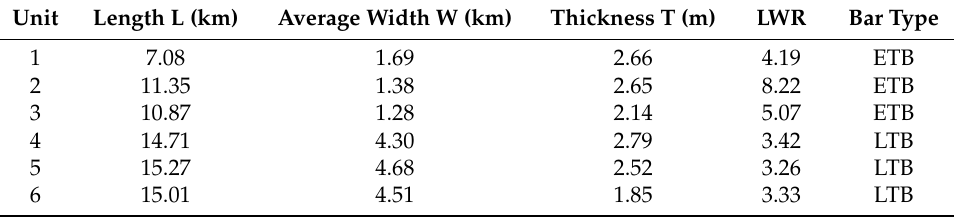
Table 2. Architectural parameters of tidal sand bars in McMurray